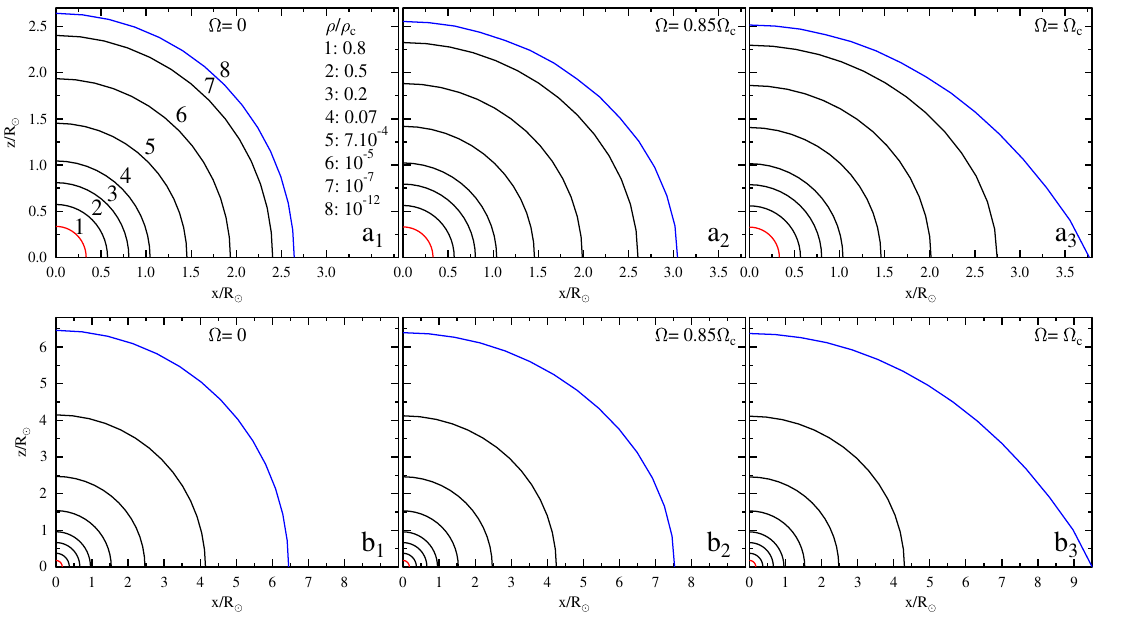
Figure 16. Rigid rotators. ( a ): Iso-density surfaces in model stars of M = 5 M (cid:12) in the ZAMS rotating at ( a 1 ) Ω = 0; ( a 2 ) Ω = 0.85 Ω c ; ( a 3 ) Ω = Ω c = 1.92 × 10 − 4 s − 1 ; ( b ): Iso-density surfaces in stars of M = 5 M (cid:12) in the TAMS rotating at ( b 1 ) Ω = 0; ( b 2 ) Ω = 0.85 Ω c ; ( b 3 ) Ω = Ω c = 4.79 × 10 − 5 s − 1 . The iso-density surfaces are labeled with the corresponding density ratios ρ / ρ c , which are the same in all panels of the figure. Adapted from Zorec [20], Zorec et al. [141]